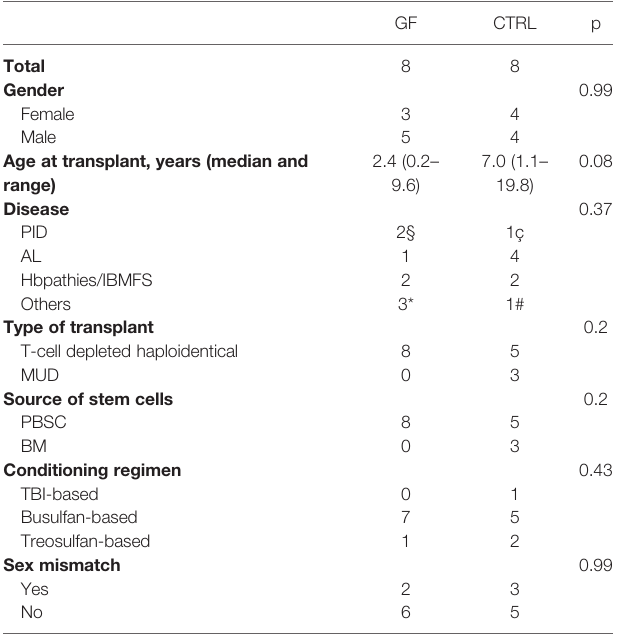
TABLE 1 | Characteristics of patients and